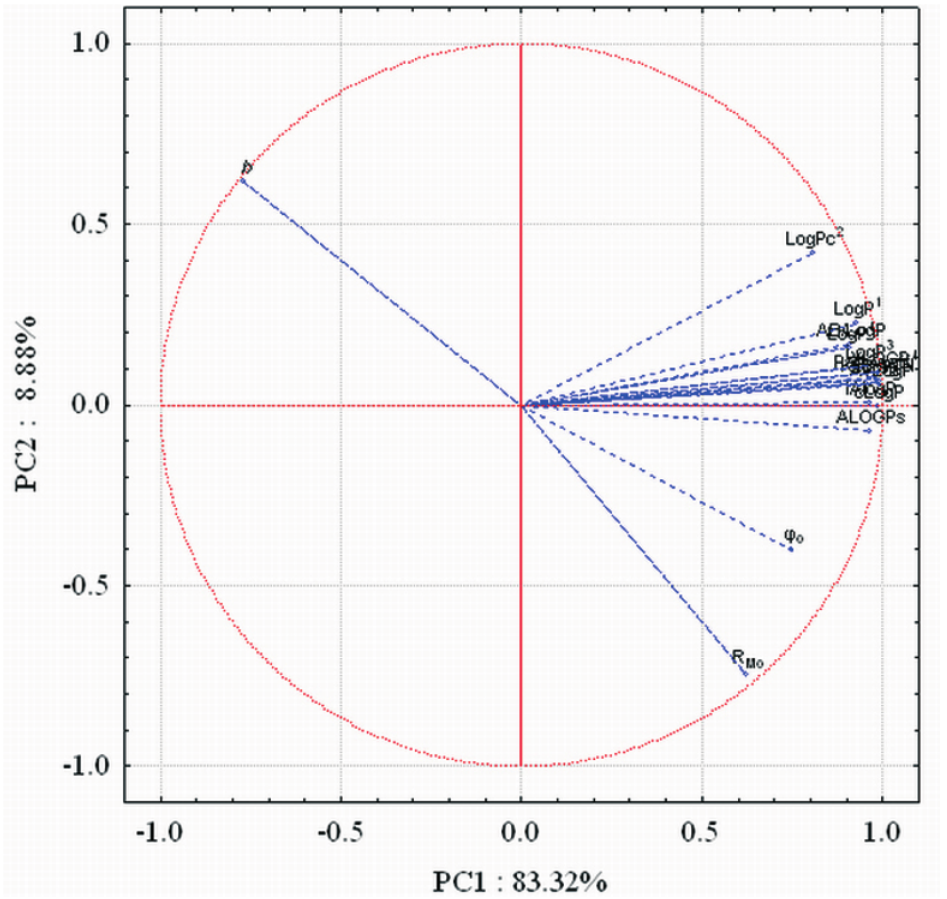
Figure 3. Scatterplot of experimental lipophilicity indices and computed Log P